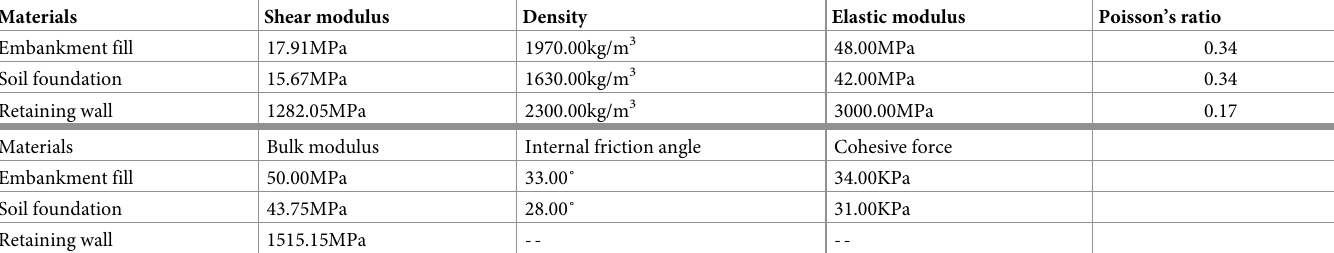
Table 2. Mechanical properties of the embankment fill, soil foundation and retaining wall.